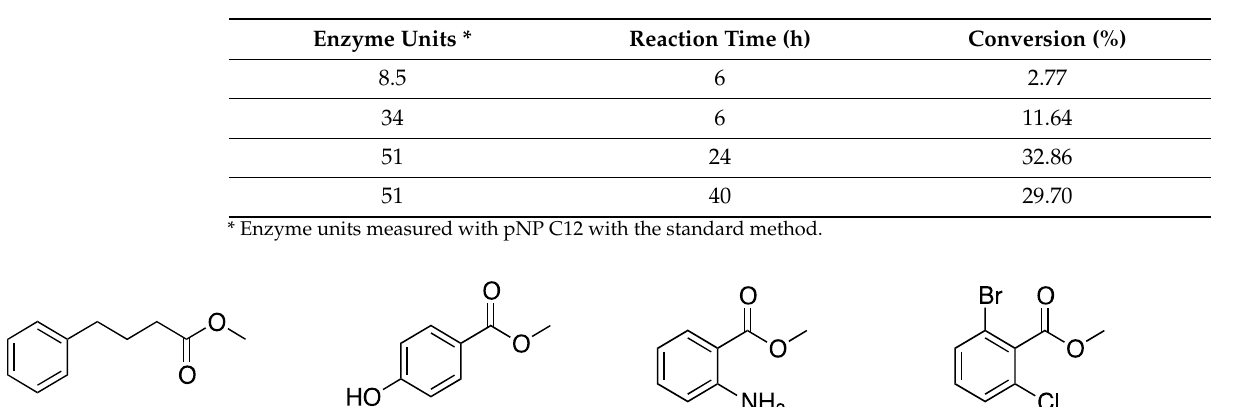
Table 4. Hydrolysis of ibuprofen methyl ester to S -ibuprofen with KLEST-3S varying enzyme amount during time. Cosolvent, 10% ( v / v ) DMF; temperature, 65 ◦ C.